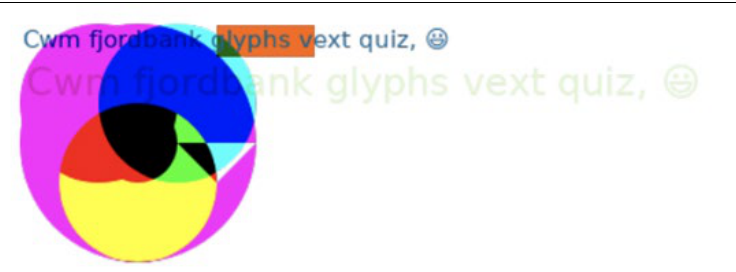
Figure 3. Canvas fingerprint generated with Akamai Bot Manager fingerprinting script.